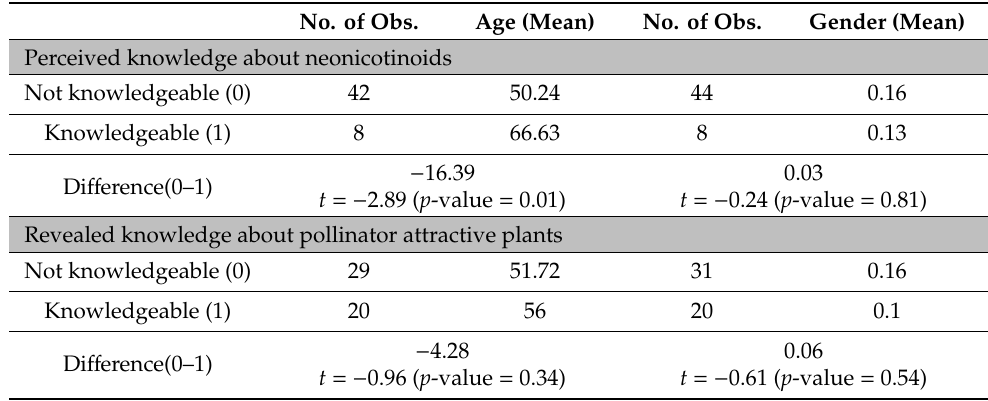
Table A2. Age and gender comparison across knowledge and involvement variables. No. of